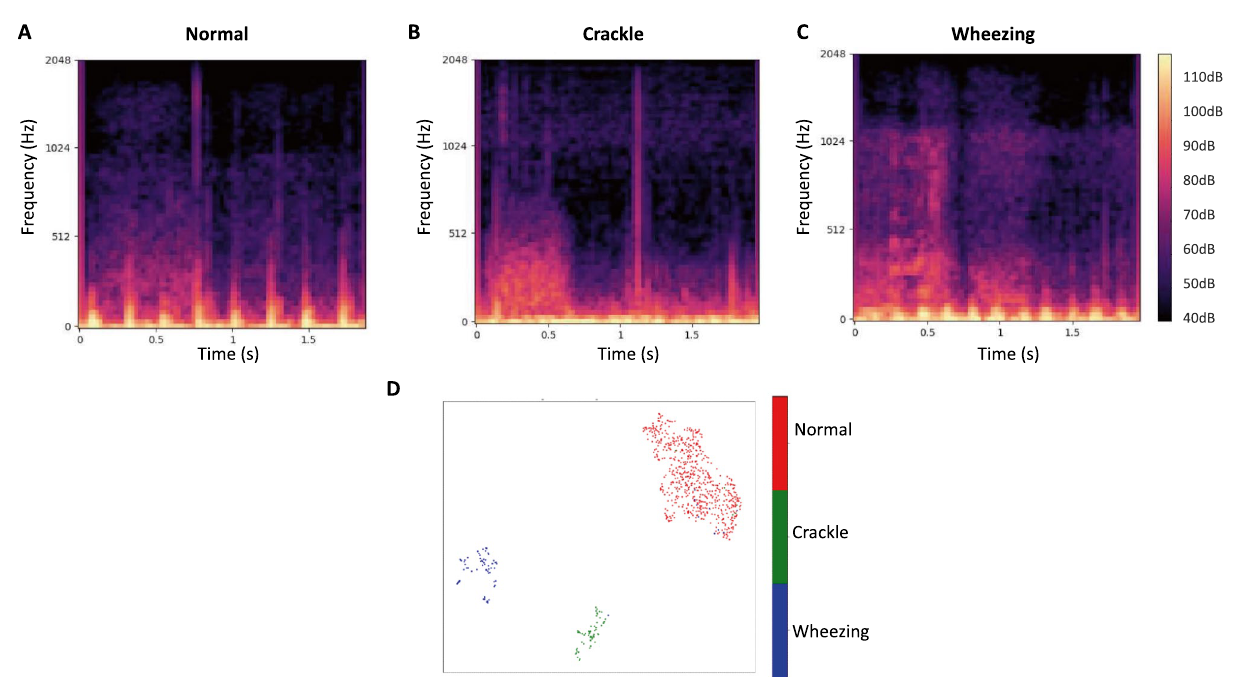
Figure 3. Mel-spectrogram and UMAP visualization of pediatric samples from publicly available lung sound dataset the International Conference on Biomedical and Health Informatics (ICBHI) 2017 Challenge Respiratory Sound Database. Mel-spectrograms labeled as normal ( A ), crackles ( B ), and wheezing ( C ), and UMAP visualization of lung sounds ( D